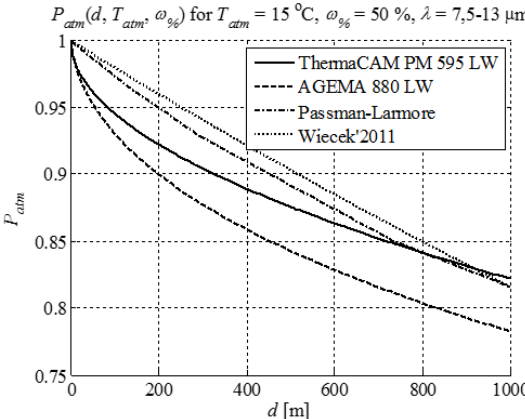
Figure 9. Characteristics of atmospheric transmission coefficient P atm = f ( d ) for a few models described in this paper for a distance up to 1000m.